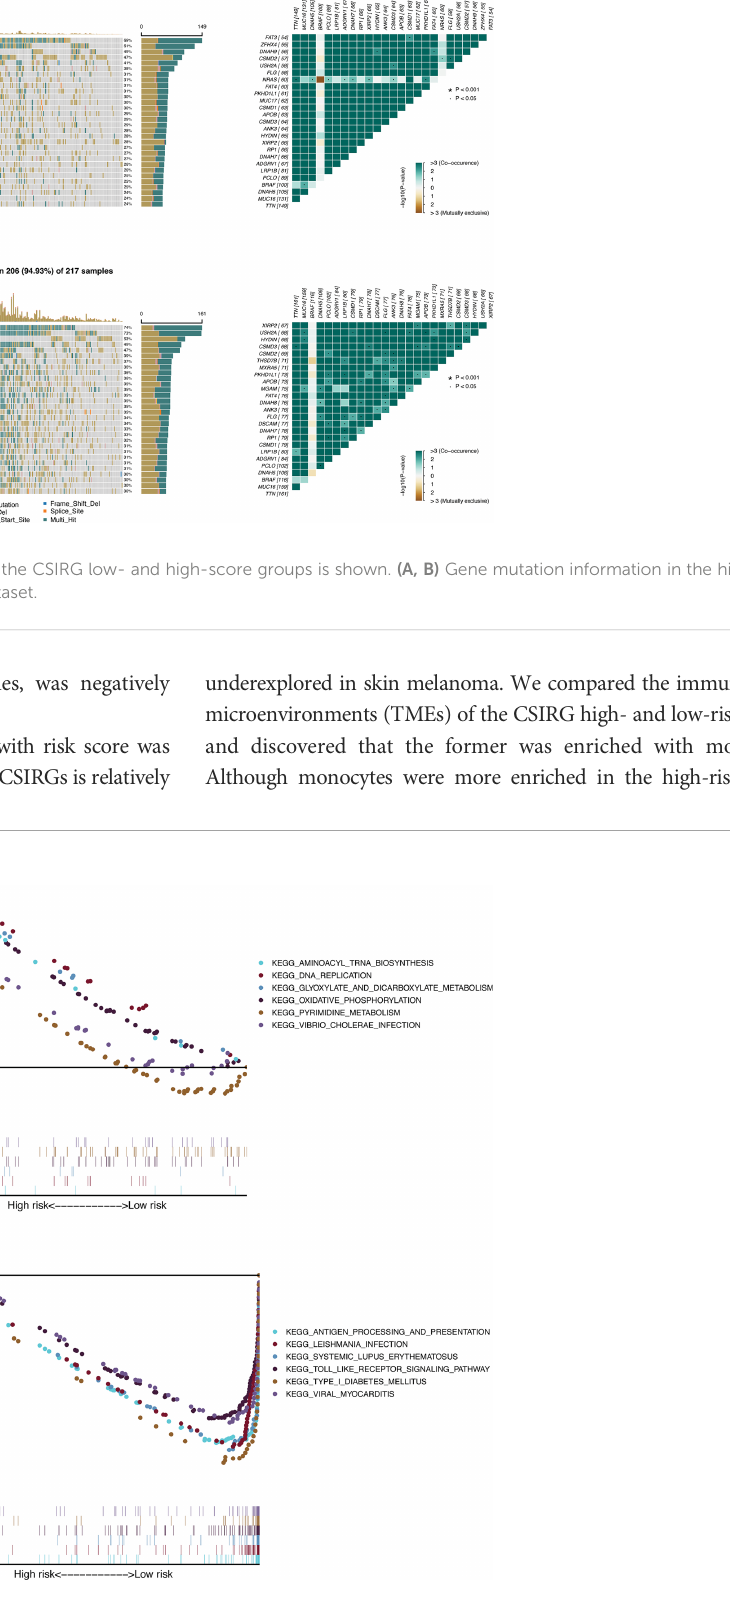
FIGURE 7 KEGG and hallmark gene set enrichment analysis for the CSIRG high-risk (A) and low-risk (B) melanoma patient groups in the TCGA